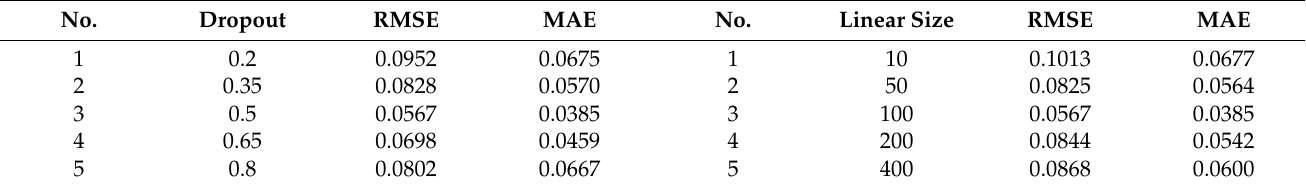
Table 5. Results of the proposed method with different dropout and linear layer output